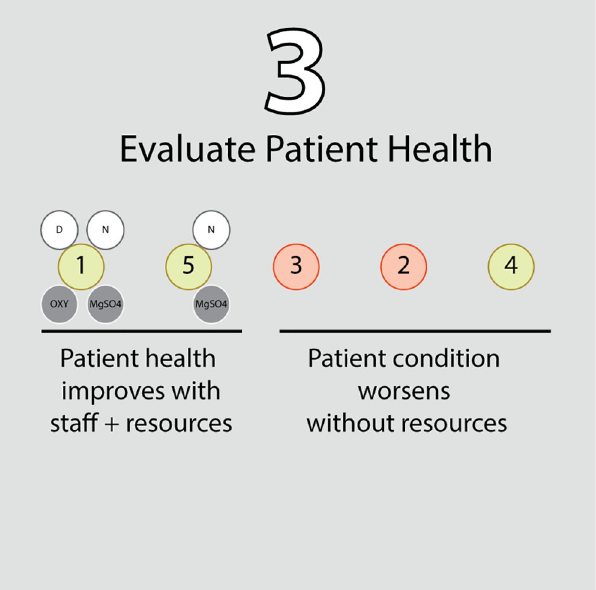
Fig 3. Schematic of the third step in the algorithm—the probabilities of mortality for patients who were treated will decrease as per the efficacy of their assigned treatment plans, while the probabilities of mortality for patients that did not get treated due to insufficient resources will increase based on the deterioration rates of their respective complications (if any).